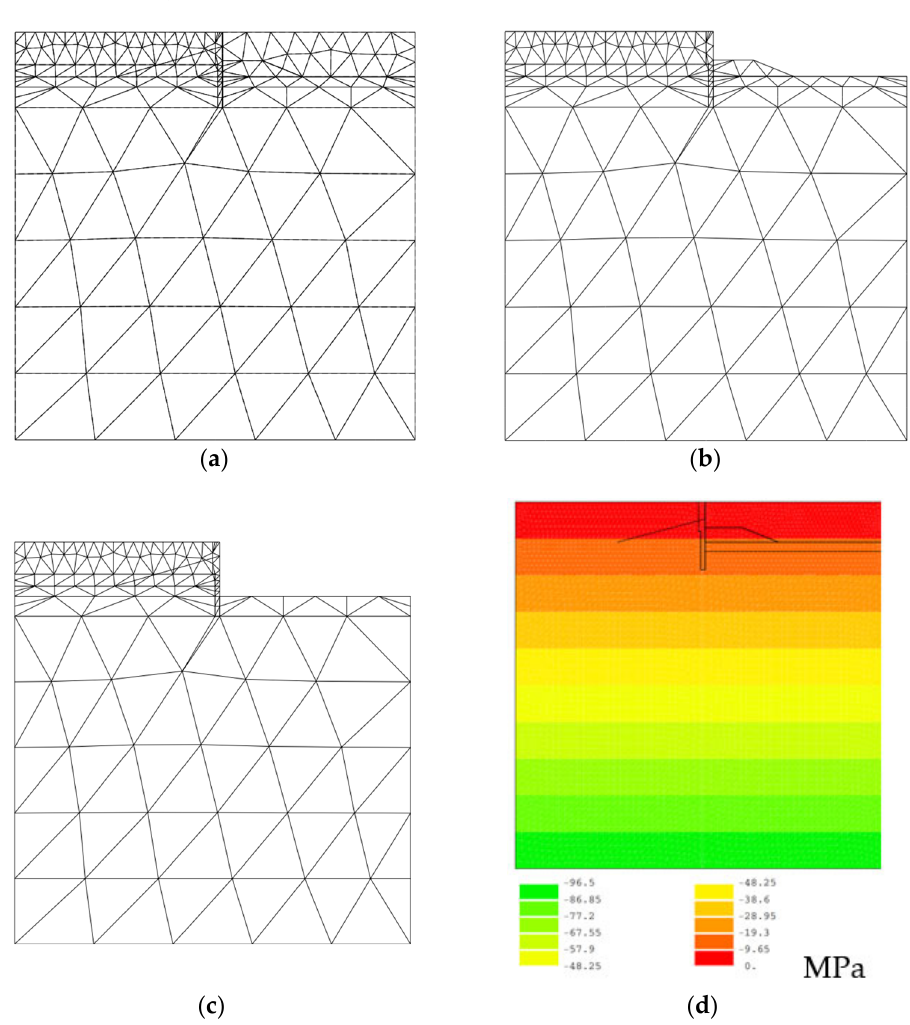
Figure 7. Mesh diagram for the 2D finite element analysis: ( a ) original mesh that was not yet excavated; ( b ) first stage of excavation; ( c ) second stage of excavation; ( d ) iso-value of the initial vertical stress.